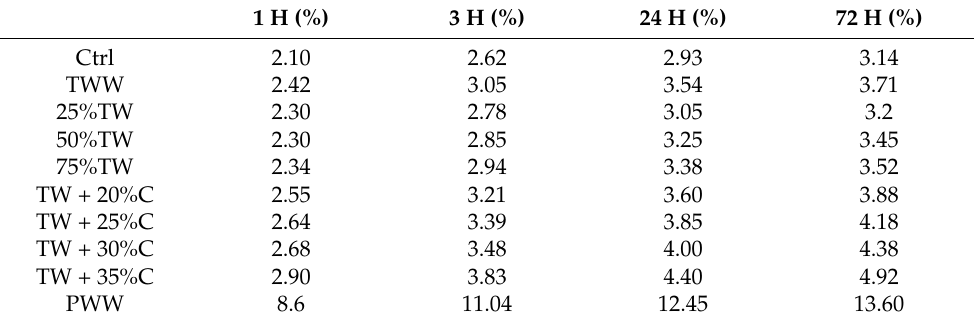
Table 6. Mass water